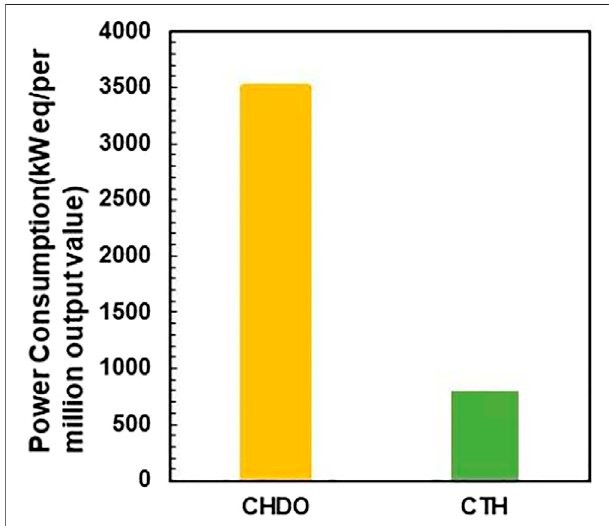
FIGURE 7 | Power consumption of CHDO and CTH scheme.